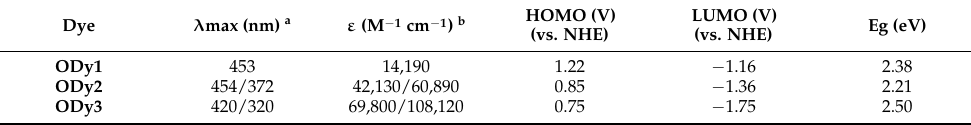
Table 2. Electrochemical data, absorption maxima and molar extinction coefficients.